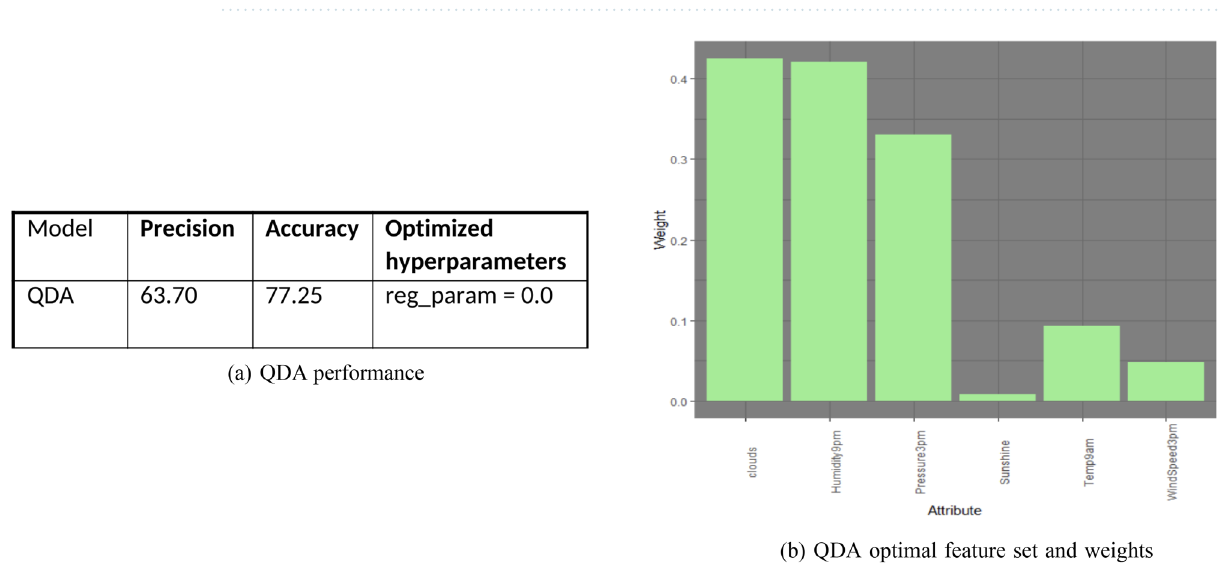
Figure 12. QDA performance and feature